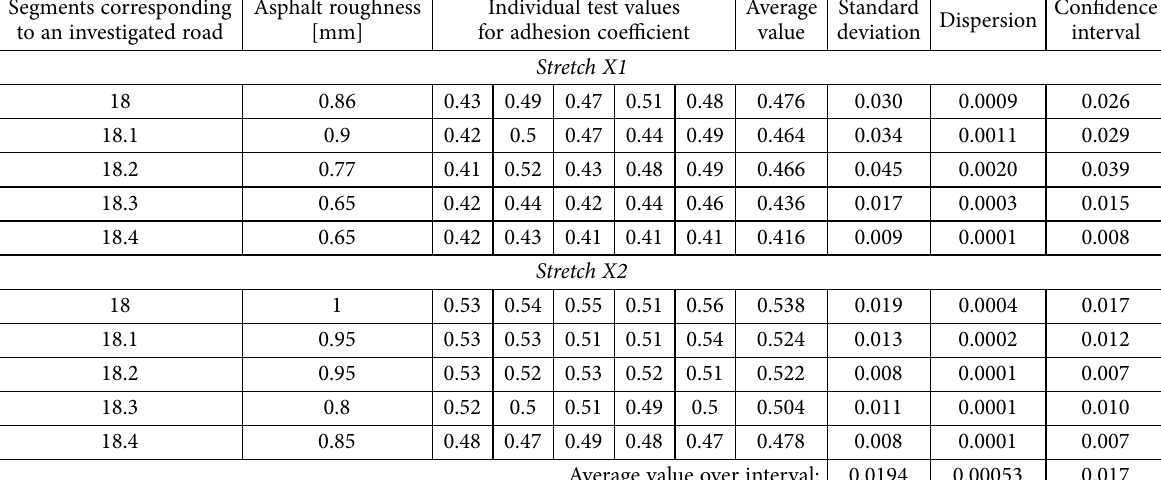
Table 1. Adhesion coefficient’s measurements and statistical analysis of the results Asphalt roughness Individual test values [mm] for adhesion coefficient